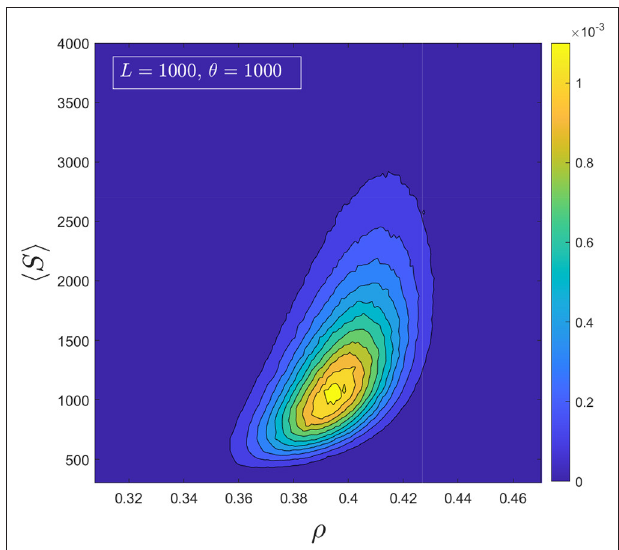
FIGURE 7 | Heatmap representing the bivariate histogram of the average cluster size and the density.